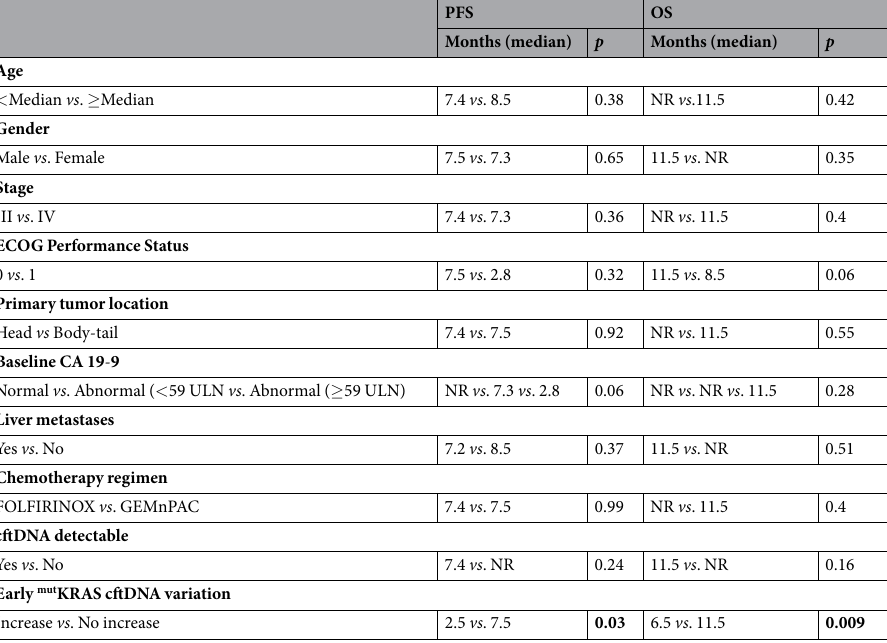
Table 2. Univariate analysis for the correlation of PFS and OS with clinical status of patients. ULN: upper limit of